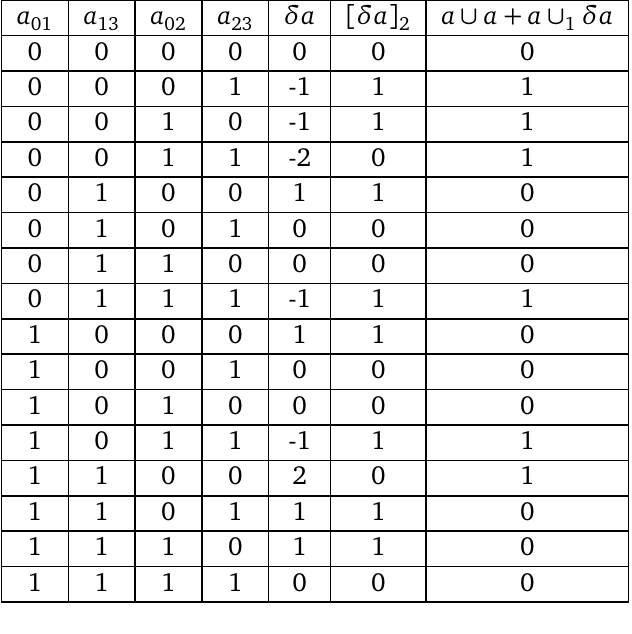
Table 3: The table enumerates all cases of ( a them satisfy Eq.